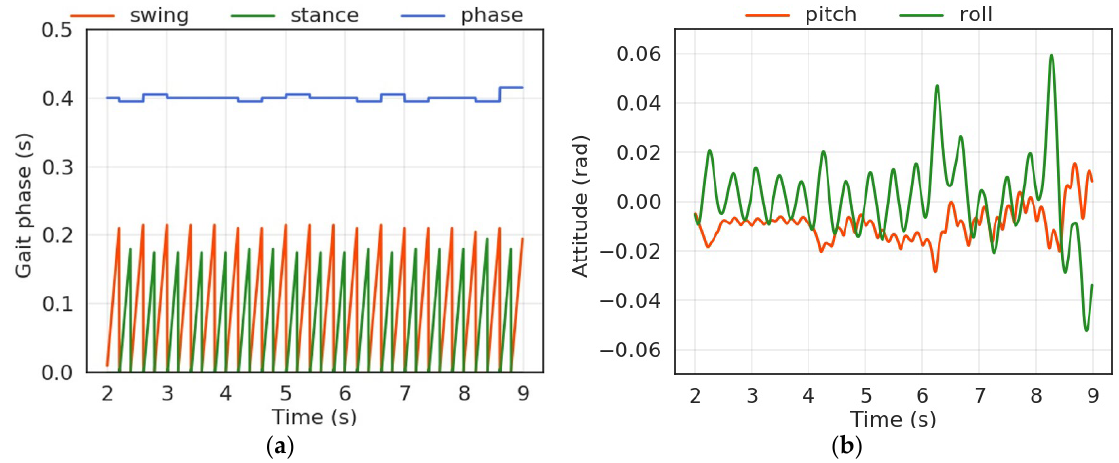
Figure 9. Motion controlled by fixed parameter PDMPC. ( a ) Gait; ( b ) Attitude angle.